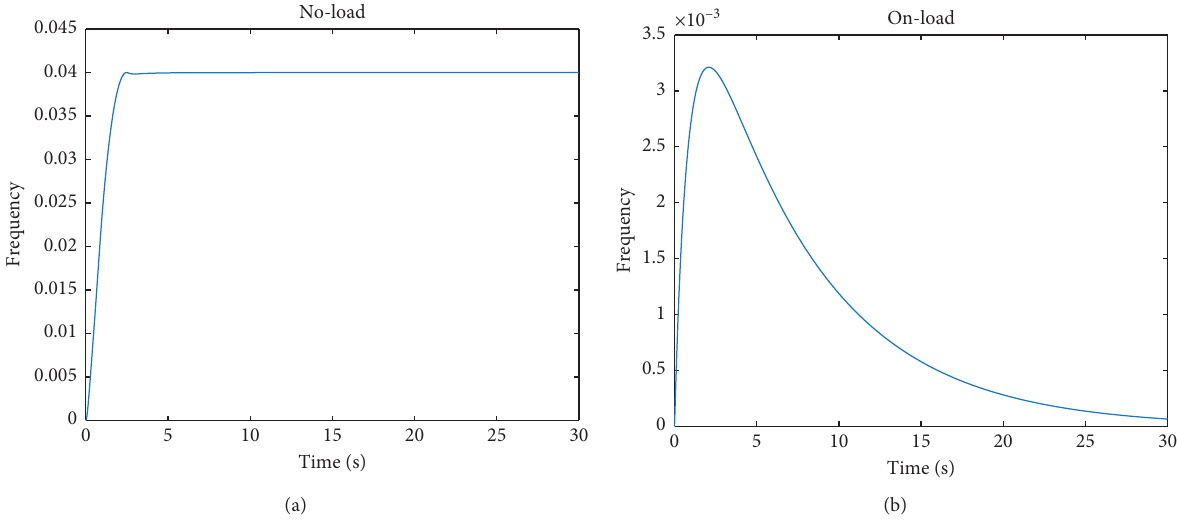
Figure 4: Control effects of the same parameter under two operating conditions. (a) No-load operating condition; (b) on-load operating